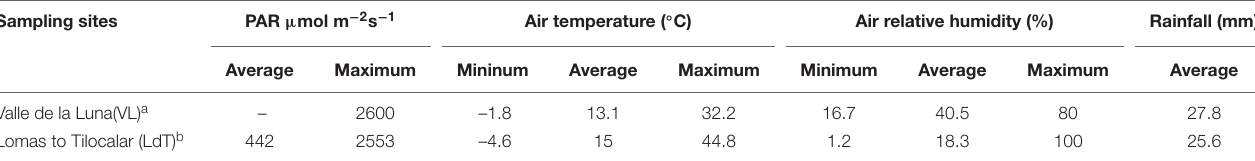
TABLE 1 | Microclimate data for the VL (calcite) and LdT (ignimbrite) sampling sites. Sampling sites